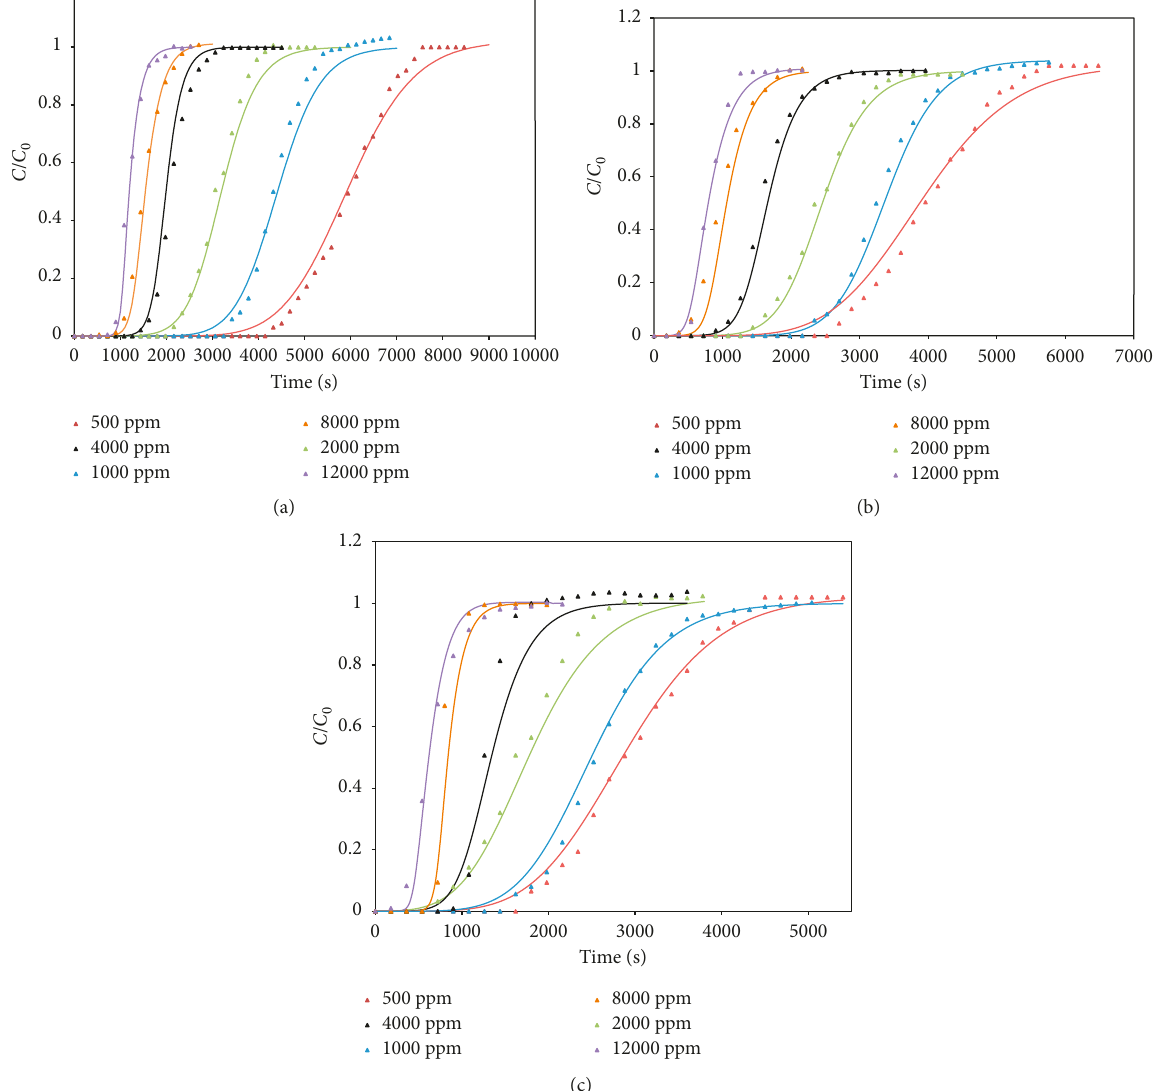
Figure 5: Breakthrough curves for dichloromethane adsorption on activated carbon at (a) 298K, (b) 313 K, (c) 323K. Symbols: experimental data. Lines: LDF